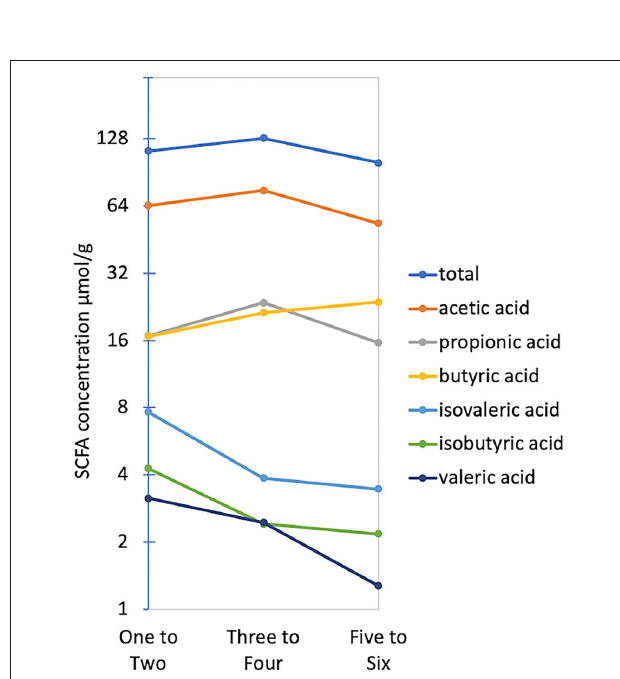
with brain cells via G-protein-coupled receptors (Abdelli et al., 2019). Although, in this study, we found no such